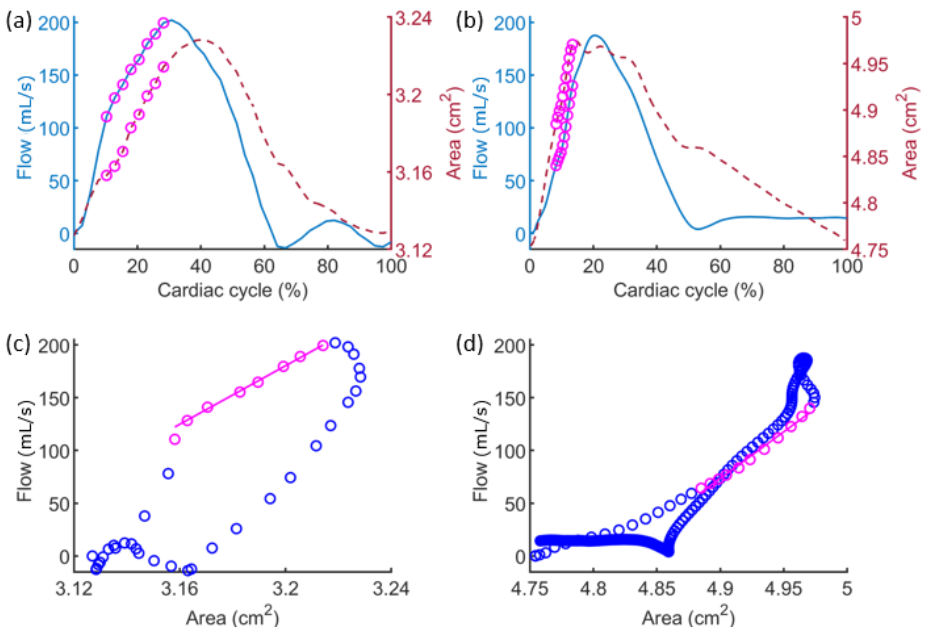
Figure 9. Flow (blue solid line) and area (red dashed line) variations with highlighted points considered for linear fitting (magenta circles) for the U-shaped model M 1 ( a ) and the patient-specific aortic model M 2 ( b ) and corresponding QA loops in dark blue circles ( c , d ), referred to slice S 3 and E = 1.7 MPa.